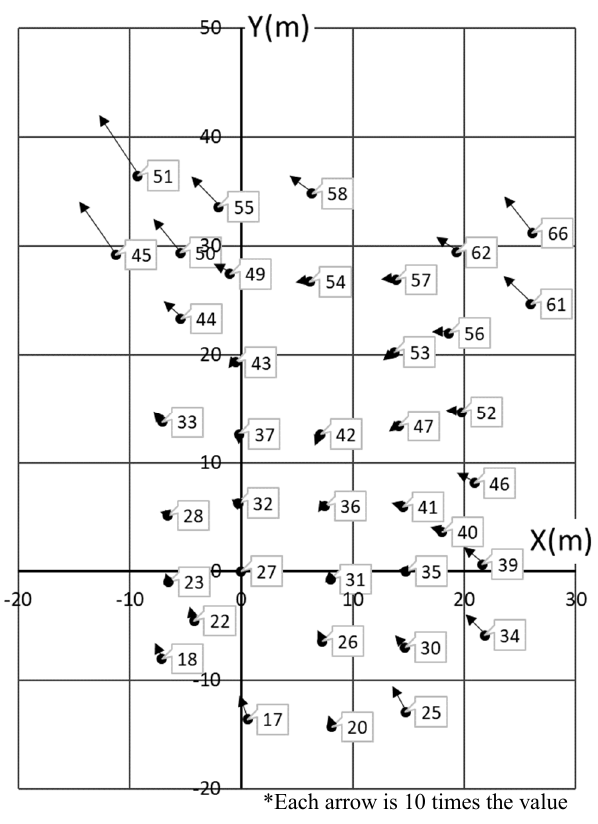
Figure 10. Error distribution of the proposed